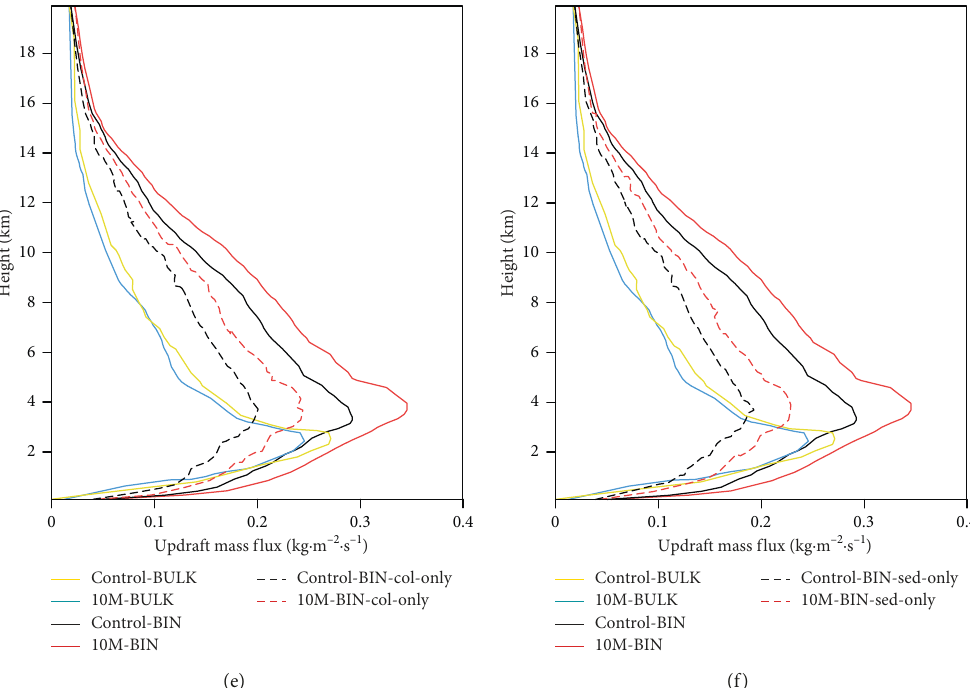
Figure 11: (a) Vertical distributions of the time- and domain-averaged updraft mass fluxes for the standard runs, the control-BIN-cdnc- only run, the 10M-BIN-cdnc-only run, the control-BULK-cdnc-only run, and the 10M-BULK-cdnc-only run. (b) Vertical distributions of the time- and domain-averaged updraft mass fluxes for the standard runs, the control-BIN-no-rain-evp-only run, the 10M-BIN-no-rain- evp-only run, the control-BULK-no-rain-evp-only run, and the 10M-BULK-no-rain-evp-only run. (c) Vertical distributions of the time- and domain-averaged updraft mass fluxes for the standard runs, the control-BIN-no-cld-evp-only run, the 10M-BIN-no-cld-evp-only run, the control-BULK-no-cld-evp-only run, and the 10M-BULK-no-cld-evp-only run. (d) Vertical distributions of the time- and domain- averaged updraft mass fluxes for the standard runs, the control-BIN-sat-only run, and the 10M-BIN-sat-only run. (e) Vertical distributions of the time- and domain-averaged updraft mass fluxes for the standard runs, the control-BIN-col-only run, and the 10M-BIN-col-only run. (f) Vertical distributions of the time- and domain-averaged updraft mass fluxes for the standard runs, the control-BIN-sed-only run, and the 10M-BIN-sed-only